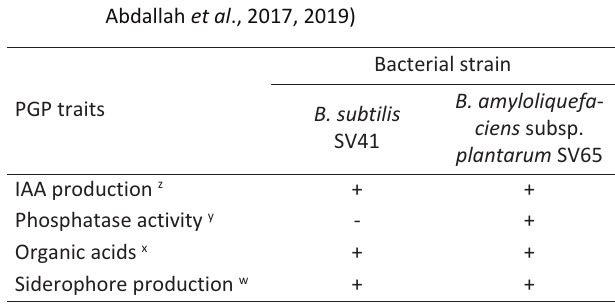
Table 1 ­ Plant growth­promoting (PGP) traits of Bacillus subtilis SV41 and Bacillus amyloliquefaciens subsp.